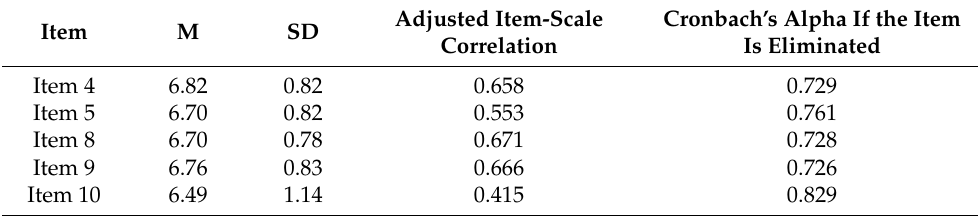
Table 5. Statistical total-item: Acceptance. Item